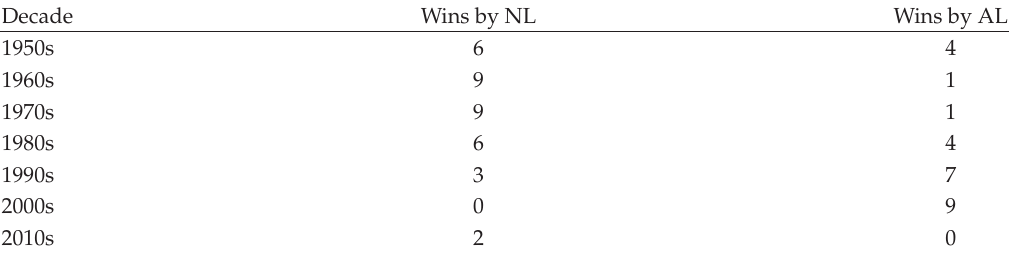
Table 4: Decadal summary of National League and American League wins in the All-Star game from 1950 to